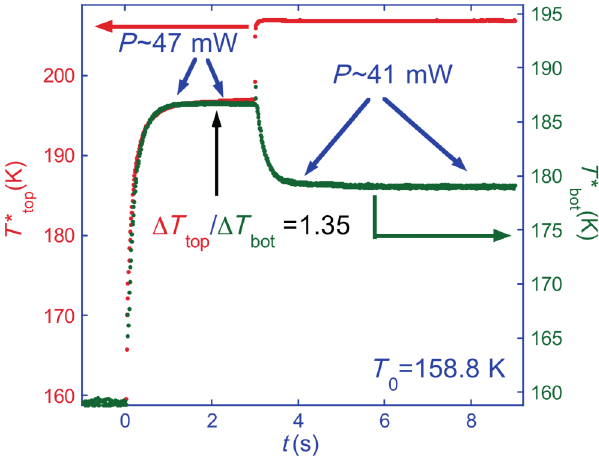
FIG. 4. The time dependencies of the response of crystal A after a high current of 30.5 mA is applied at t ¼ 0 . The temperatures T (cid:3) and T (cid:3) are derived by matching the measured time- top bot dependent Y and Y to the corresponding low-current top bot Y ð T Þ and Y ð T Þ ; see Fig. 3(b). These data are scaled to top bot match for t < 3 s, where the responses differ only by a scaling factor. In this scaling regime, the Δ T (cid:3) is larger (by about 35%) top than Δ T (cid:3) , and this is consistent with simple heating and the fact bot that the heat due to the high current is applied to the top surface. For t > 3 s, something else happens — see the text.